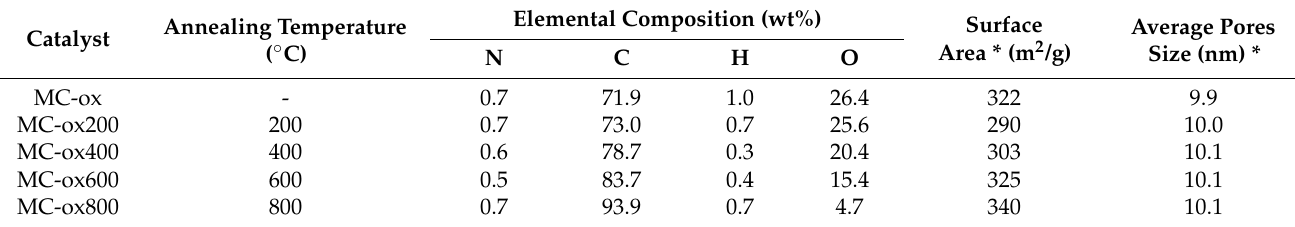
Table 3. Elemental composition and textural properties of functionalized MC samples. MC-ox refers to the oxidized MC, which was subjected to an annealing step at temperatures between 200–800 ◦ C.